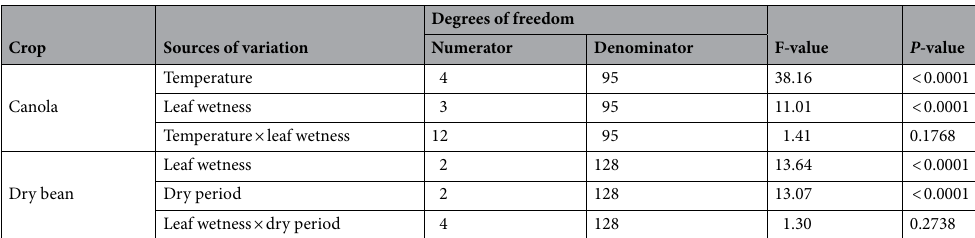
Table 1. Analysis of variance of the effect of incubation temperature and interrupted leaf wetness period and of interrupted leaf wetness on diseases incidence caused by Sclerotinia sclerotiorum ascosporic infections on canola and dry bean, respectively. Analysis was conducted using the GLIMMIX procedure of SAS (version 9.4). The studies were conducted for 10 and 8 days,